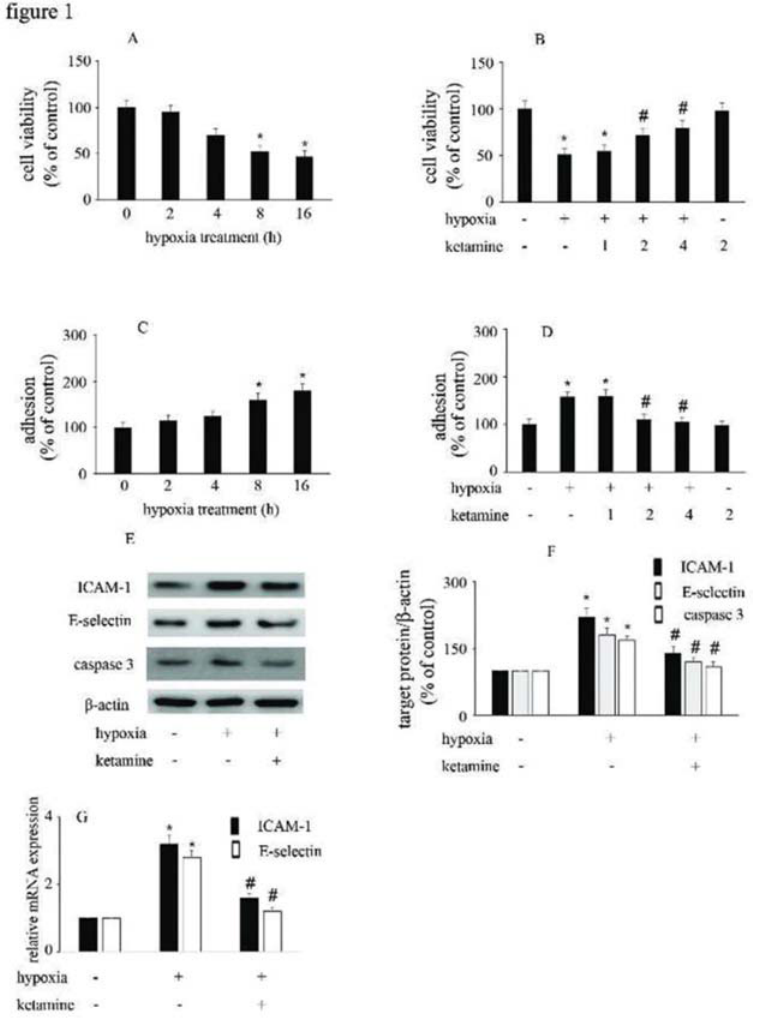
Figure 1 - The effect of ketamine on HUVEC viability and monocyte/endothelial cell adhesion following the exposure of HUVECs to hypoxia. (A) Hypoxia reduced the viability of HUVECs in a time-dependent manner. (B) Ketamine enhanced the hypoxia-mediated reduction of cell viability in a concentration-dependent manner. (C) Hypoxia increased monocyte/endothelial cell adhesion in a time- dependent manner. (D) Ketamine inhibited the hypoxia-mediated monocyte/endothelial cell adhesion in a concentration-dependent manner. The optimal concentration of ketamine that began to ameliorate the hypoxia-mediated reduction of HUVEC viability and inhibit the hypoxia-mediated monocyte/endothelial cell adhesion was 2 m g/mL. (E) Equal amounts of proteins were separated by SDS- PAGE and immunoblotted with antibodies against ICAM-1, E-selectin, and caspase-3. (F) The ratio of the protein expression of each specific protein (ICAM-1, E-selectin, and caspase 3) to the expression of b -actin (* p o 0.05 versus the control group, # p o 0.05 versus the hypoxia group,